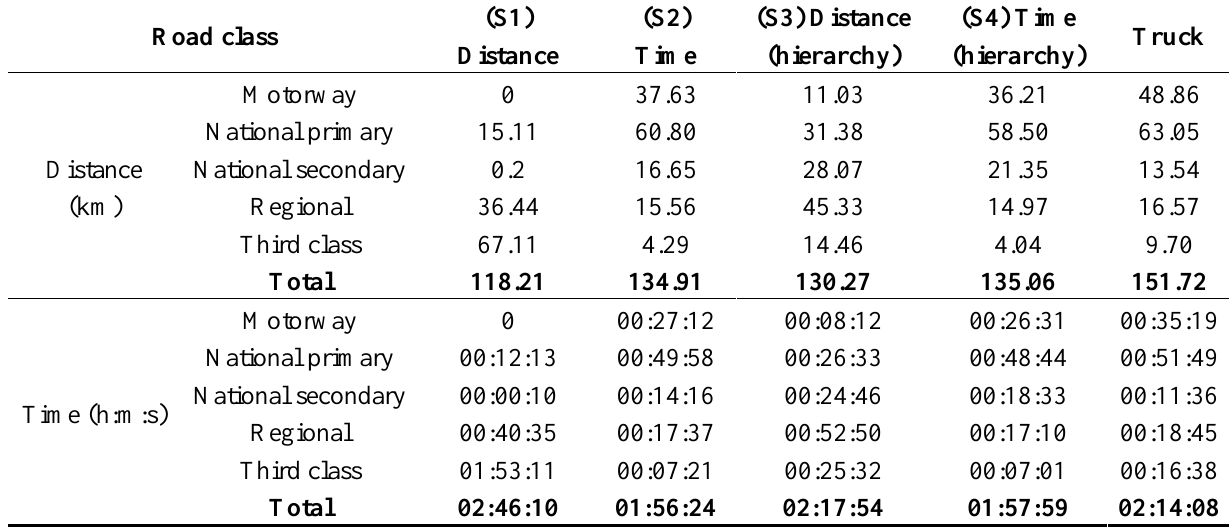
Table 5. Summary of average distances and time per route under different